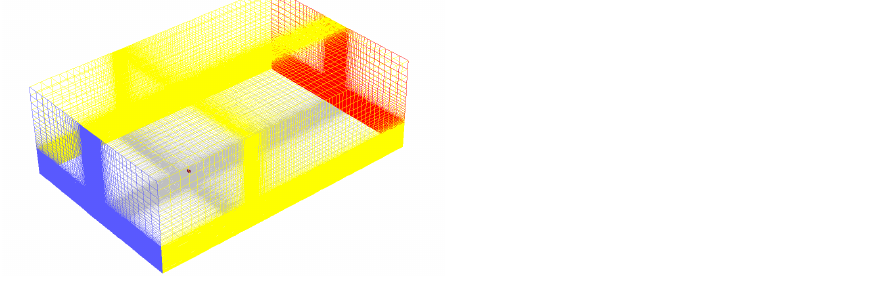
Figure 6. Background mesh (H = 2655 m, W = 5310 m, L = 7965 m). Blue, velocity inlet; red, pressure outlet; gray, no-slip wall; yellow; symmetry b.c.; purple, component mesh boundary with overset